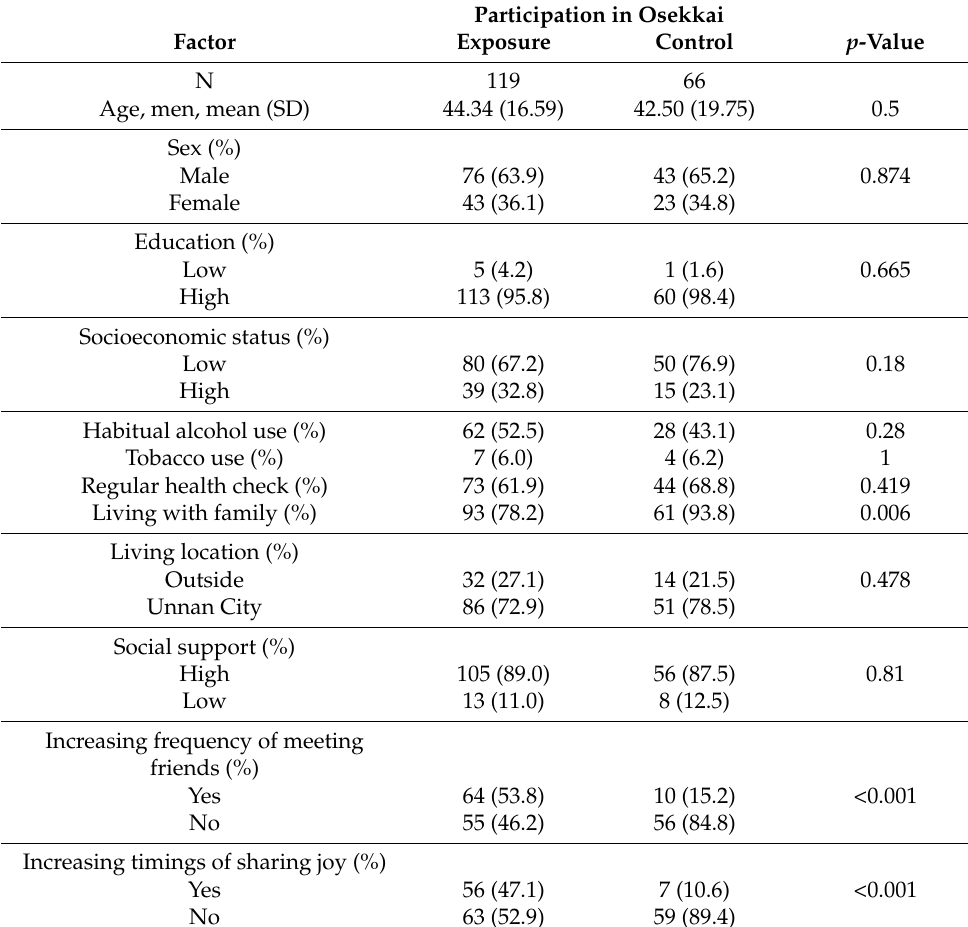
Table 1. Demographics and perception of participation in Osekkai among the